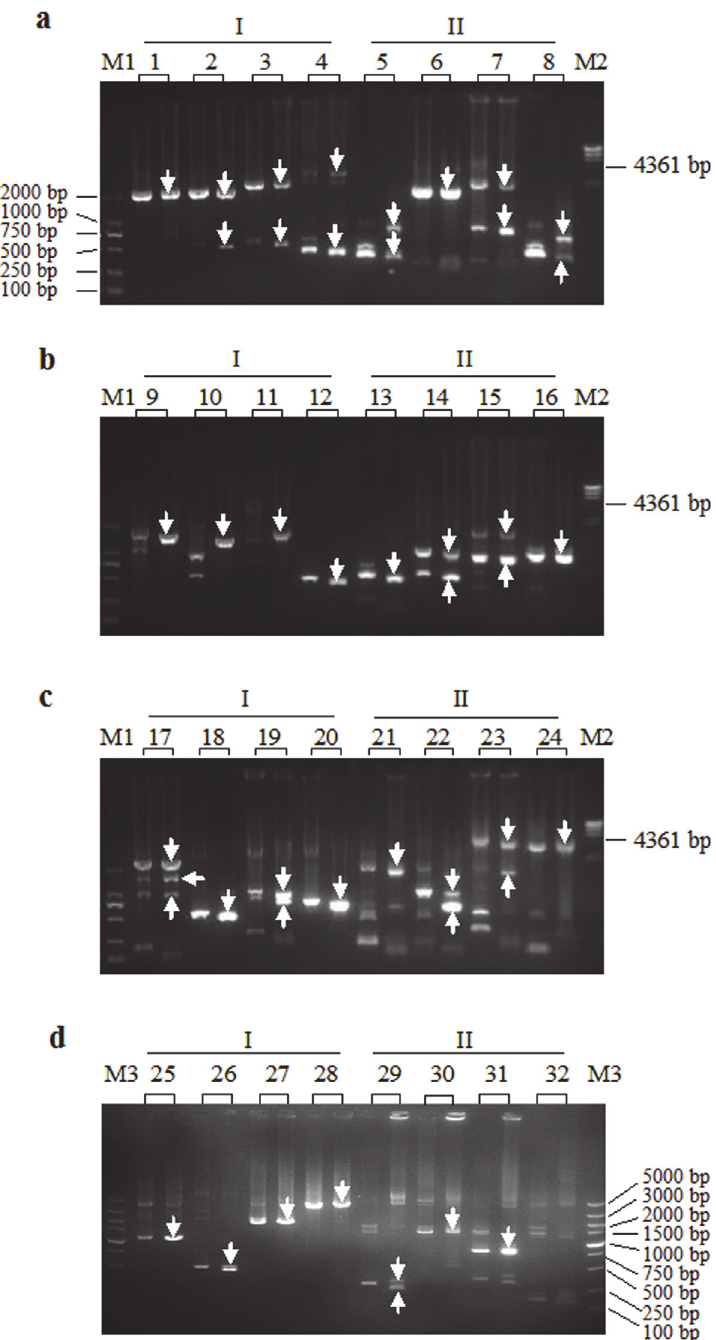
Fig 2. Chromosome walking of the gadA locus of Lactobacillus brevis NCL912 (a), human aldolase A gene (b), malQ of Pichia pastoris GS115 (c), and hyg of rice (d). I: walking into 5 ’ regions of the genes (locus); II: walking into 3 ’ regions of the genes (locus). Each walking experiment contained four sets of PCRs that respectively utilized the four POP primer sets, POP1, POP2, POP3, and POP4, paired with a specific primer set. For each set of PCRs, only the results of secondary PCR (left lane) and tertiary (right lane) PCR are presented. White arrows indicate target bands. M1: DL2000 DNA marker. M2: λ -Hind III digest DNA Marker. M3: DL5000 DNA